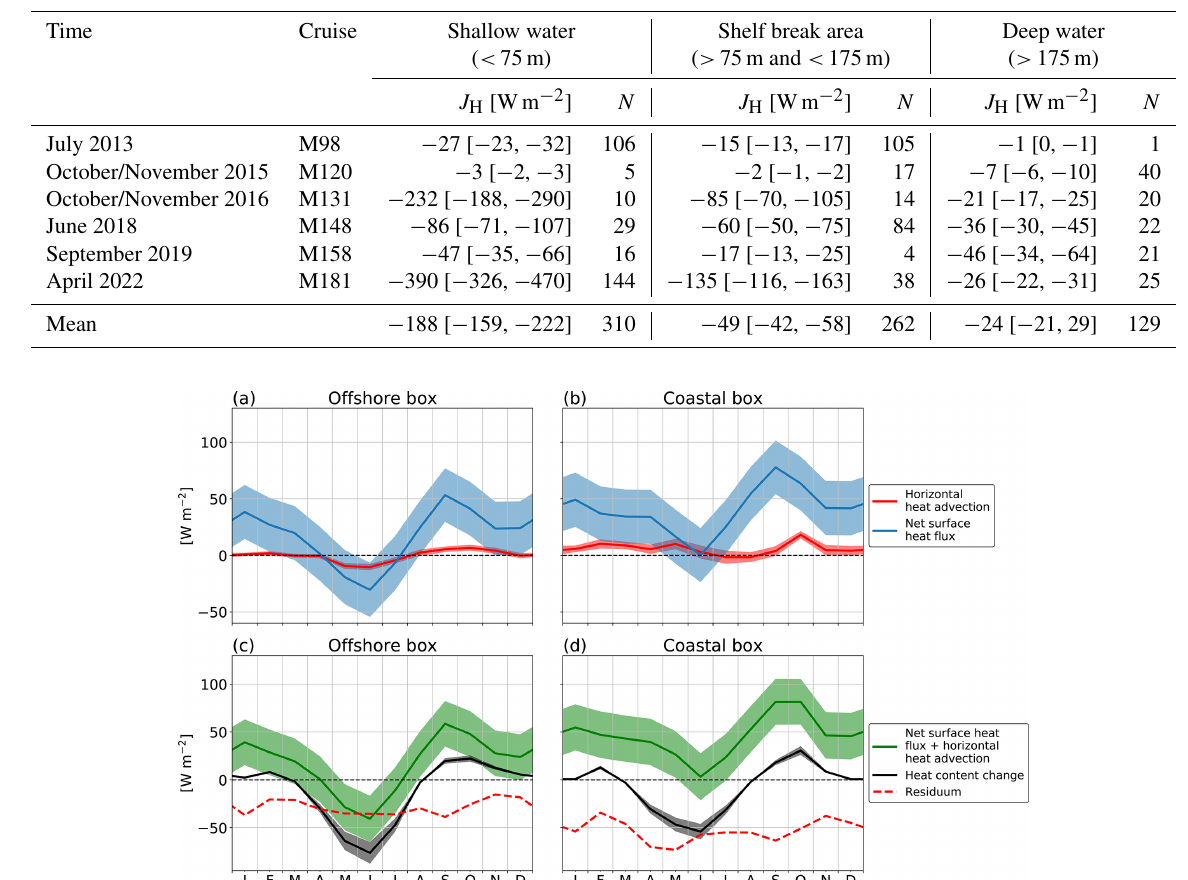
Table 2. Turbulent heat flux ( J H ) averaged between 2 and 15m below the ML during the respective cruise for profiles taken in different depth ranges. The 95% confidence interval is given in brackets below. The number of profiles in each depth range is presented as well ( N ).